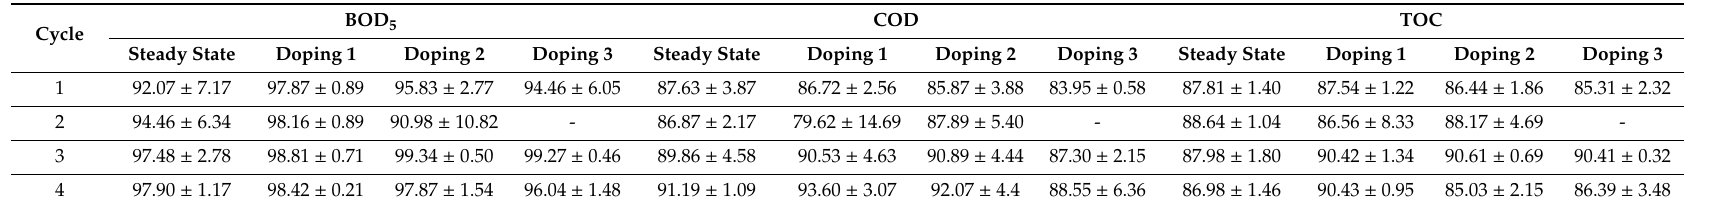
Table 4. Organic matter removal e ffi ciency of the process measured as BOD 5 , COD, and TOC during the